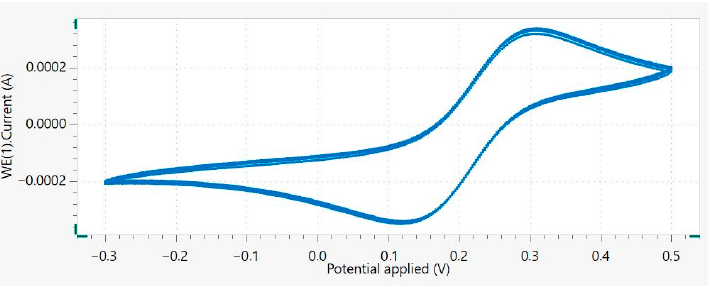
Figure 2. CV voltammogram vs. Ag.AgCl de Fe(CN) 6 5 × 10 − 3 M (in KCl 0.1 M) with commercial Pt and Au as counter electrode and working electrode, respectively.